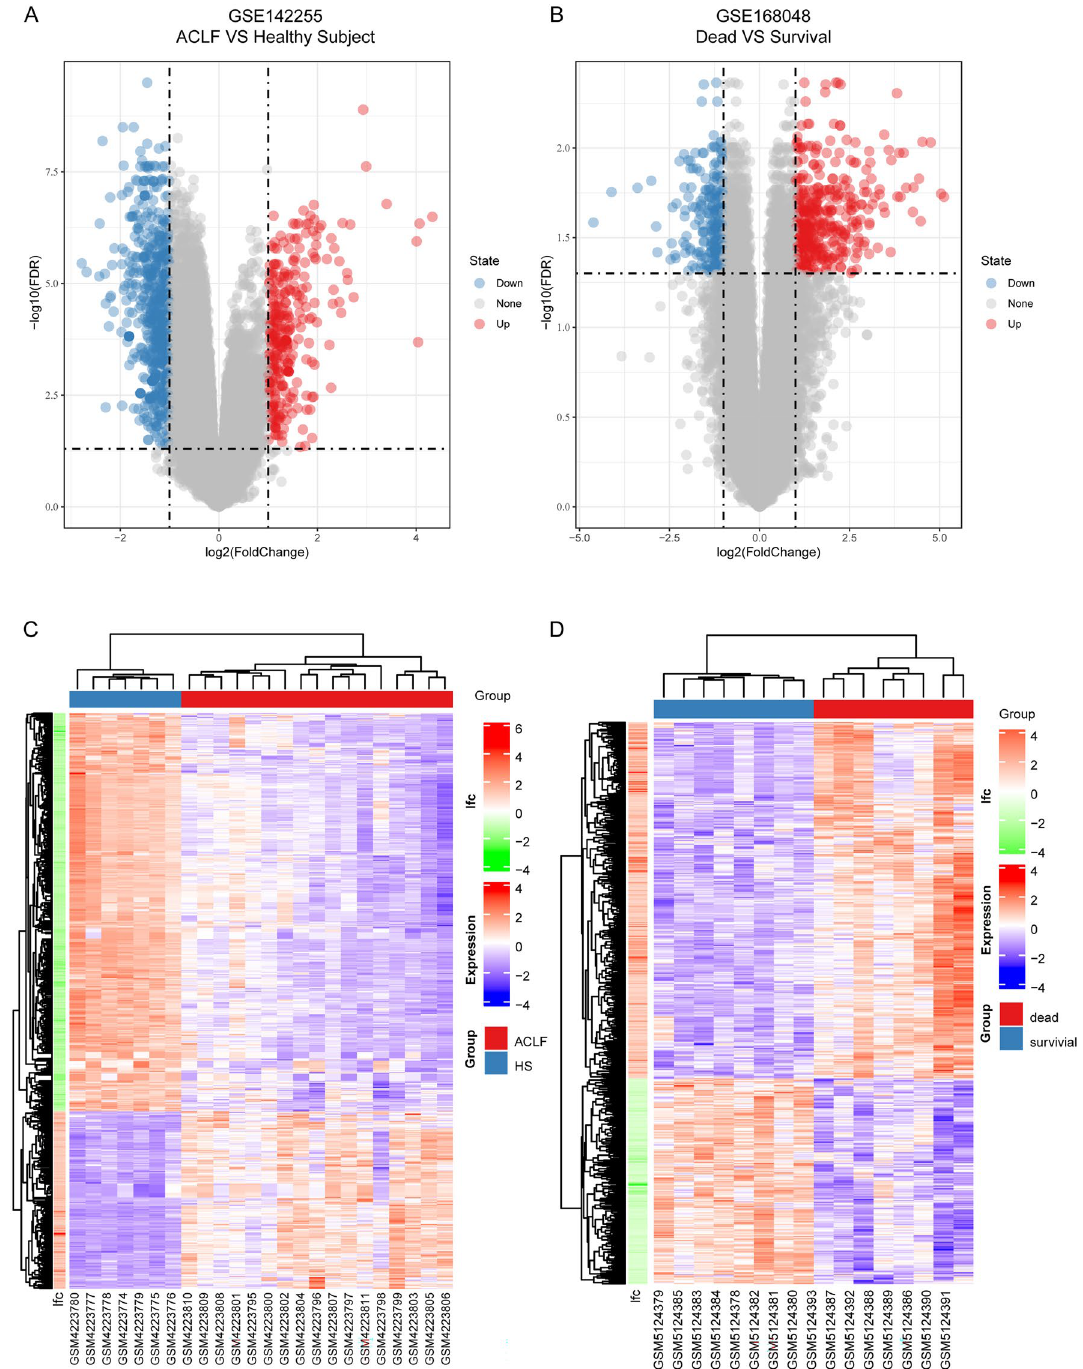
Figure 2. Visualization of gene expression on GSE142255 and GSE168048. Differentially expressed genes (DEGs) in GSE142255 ( A ) and GSE168048 ( B ) were screened with |log2 (fold change) |> 1 and adjusted p < 0.05 and are presented in a Volcano plot. Blue plots represent downregulated DEGs and red plots represent upregulated ones. The expression of DEGs of each sample in GSE142255 ( C ) and GSE168048 ( D ) was visualized in clustered heat